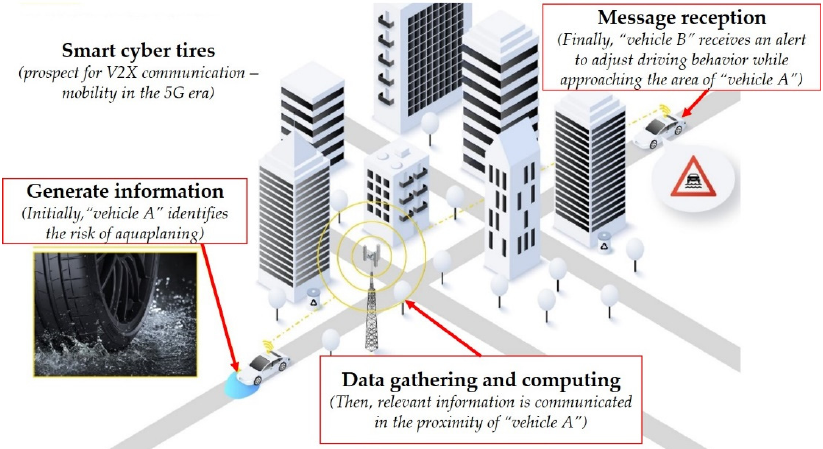
Figure 13. The concept of cyber smart tires (adapted by [95]), case of an urban road environment.